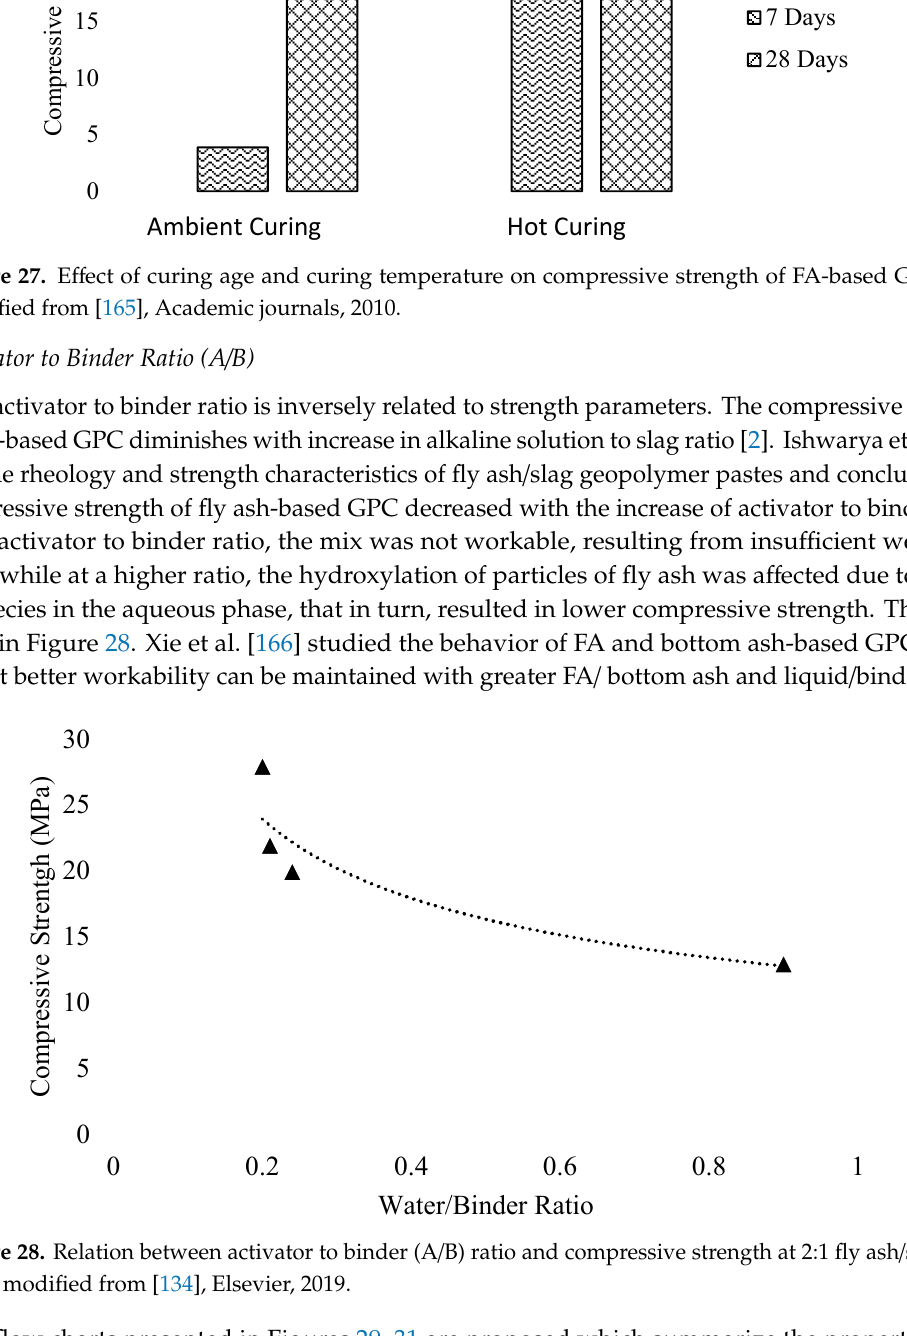
Figure 29. Fresh and hardened properties considered while determining the ratios of GPC.